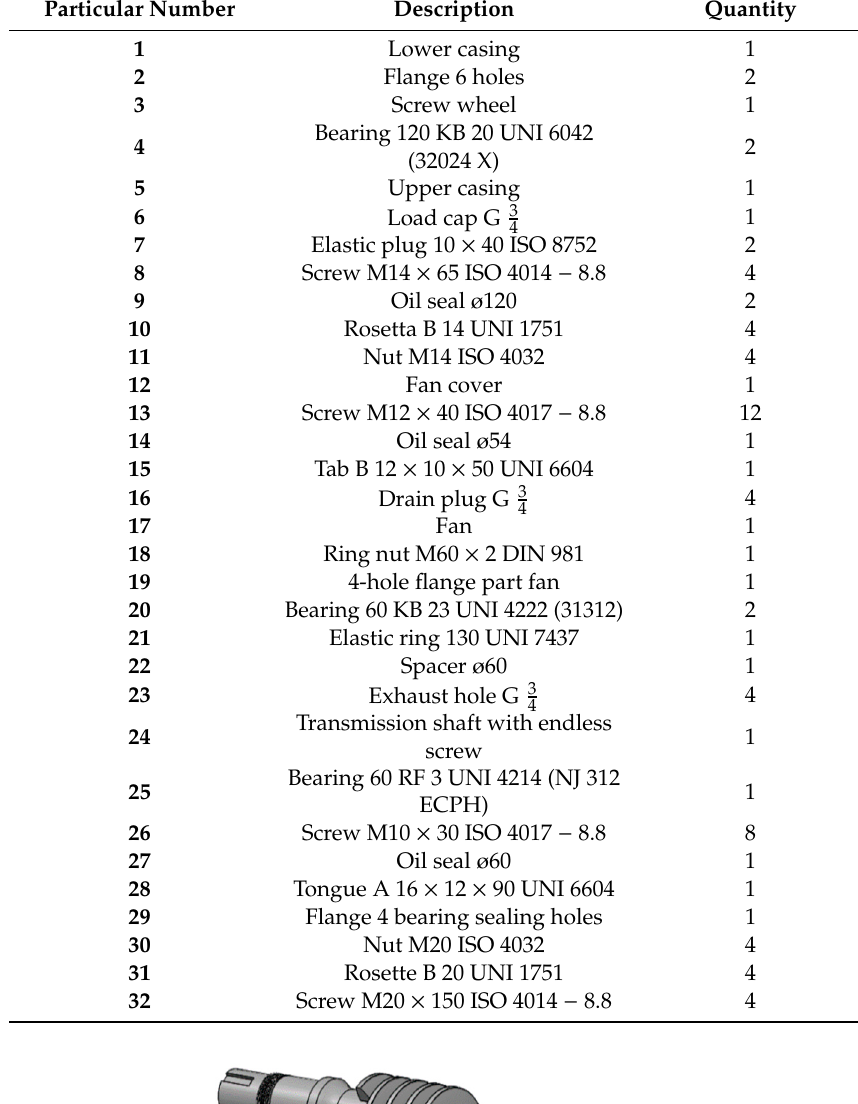
Table 1. Bill of materials (BOM).